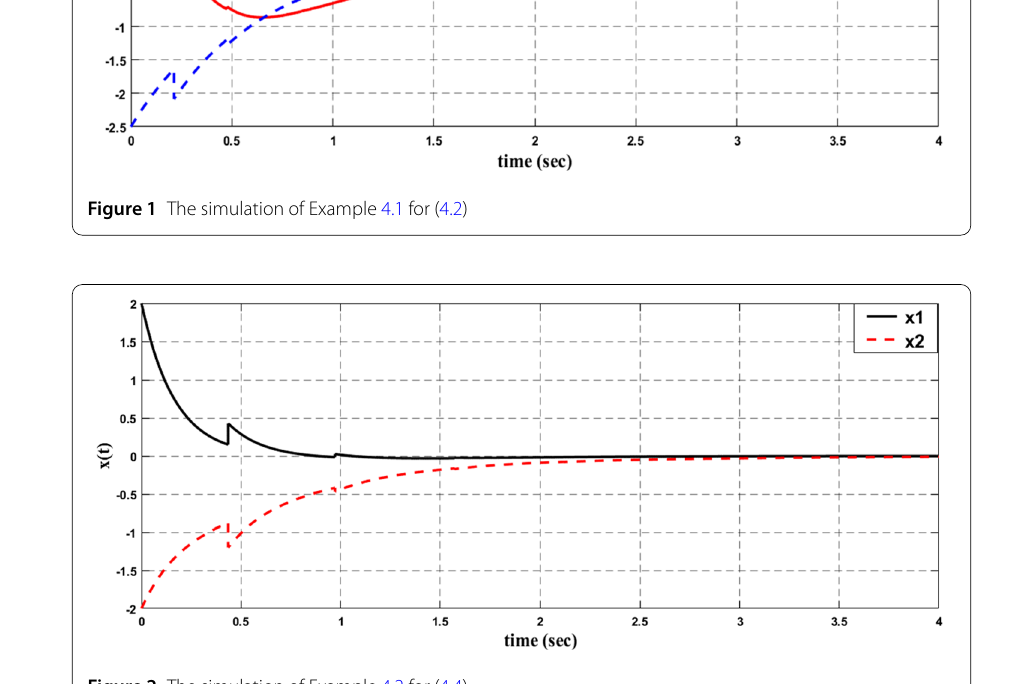
Figure 2 The simulation of Example 4.2 for (4.4)